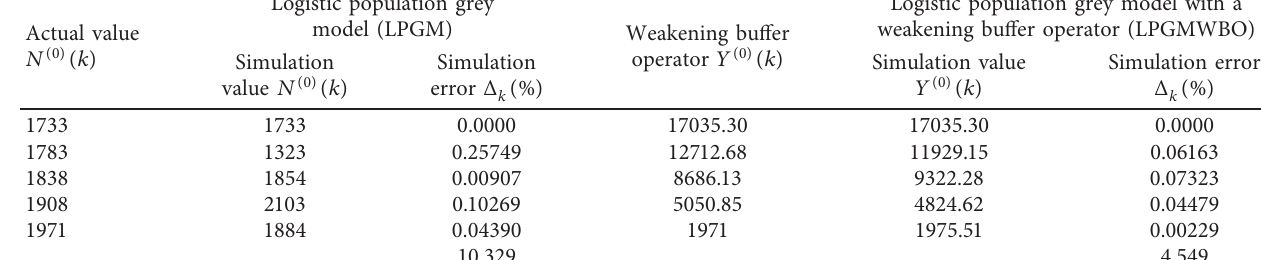
Table 11: Simulated and MAPE values for the two models of urban population size in Chongqing, China. Actual value N ( 0 ) ( k )